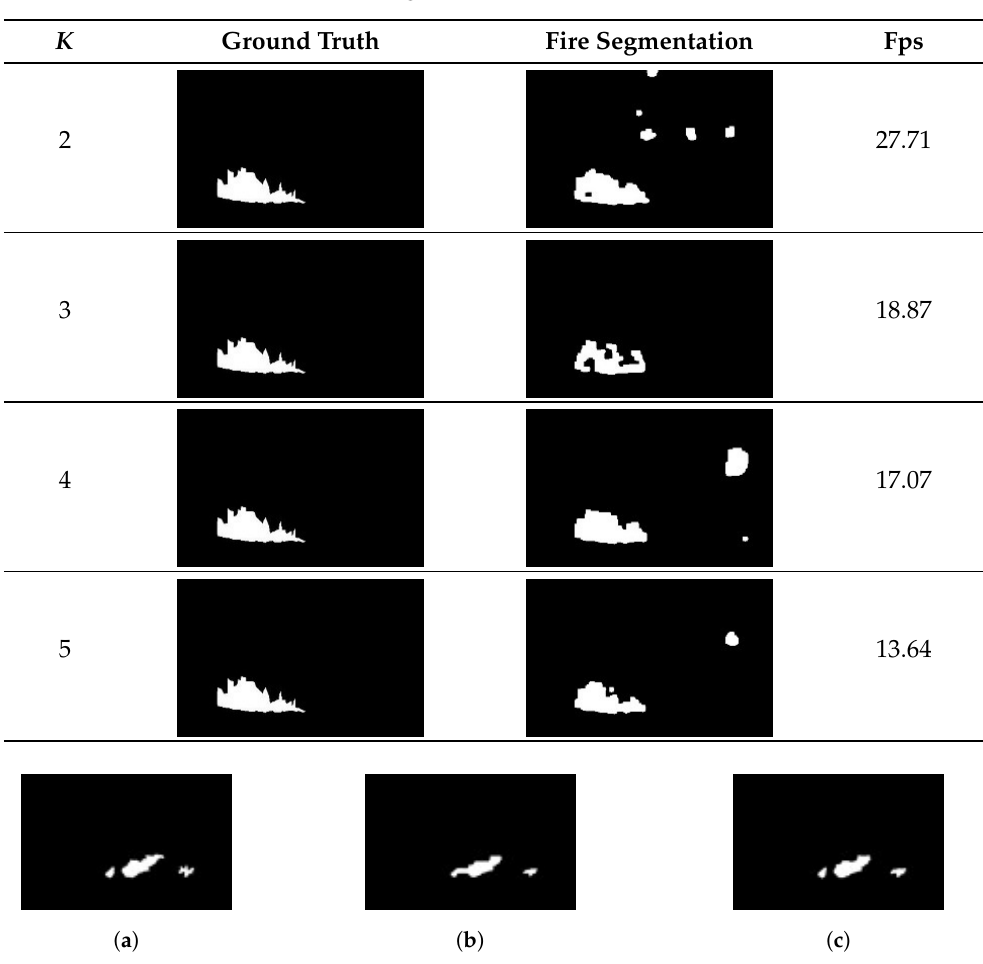
Table 2. The effect of the value of K in segmentation results.